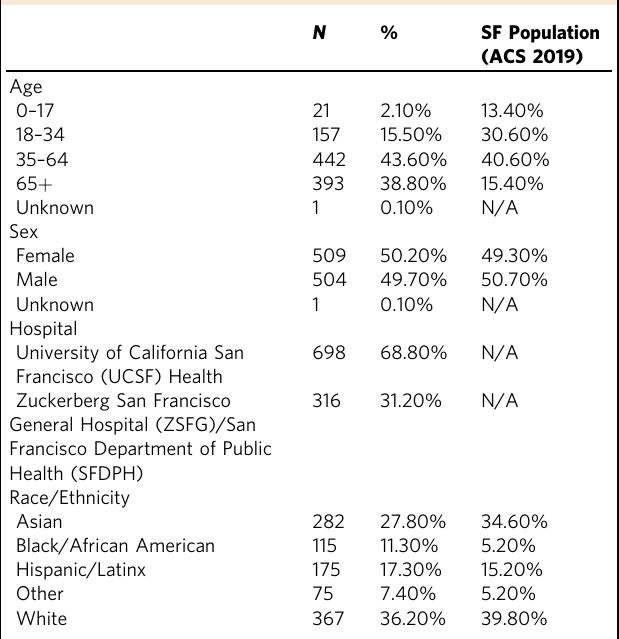
Table showing the sample size and distribution of the sample population by demography and hospital system, compared to the San Francisco Population as determined by the American Community Survey 2019 15 .